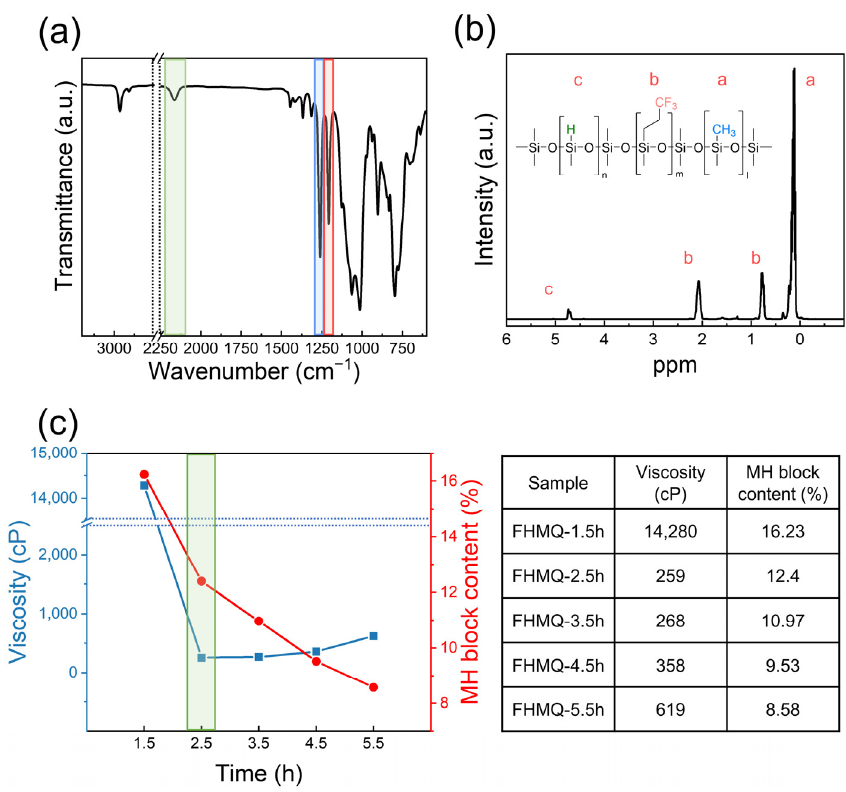
Figure 6. ( a ) FT-IR spectrum of the FHMQ-2.5h; ( b ) 1 H-NMR spectrum of FHMQ-2.5h, and ( c ) MH- block content and viscosity data of all FHMQs with respect to reaction time.